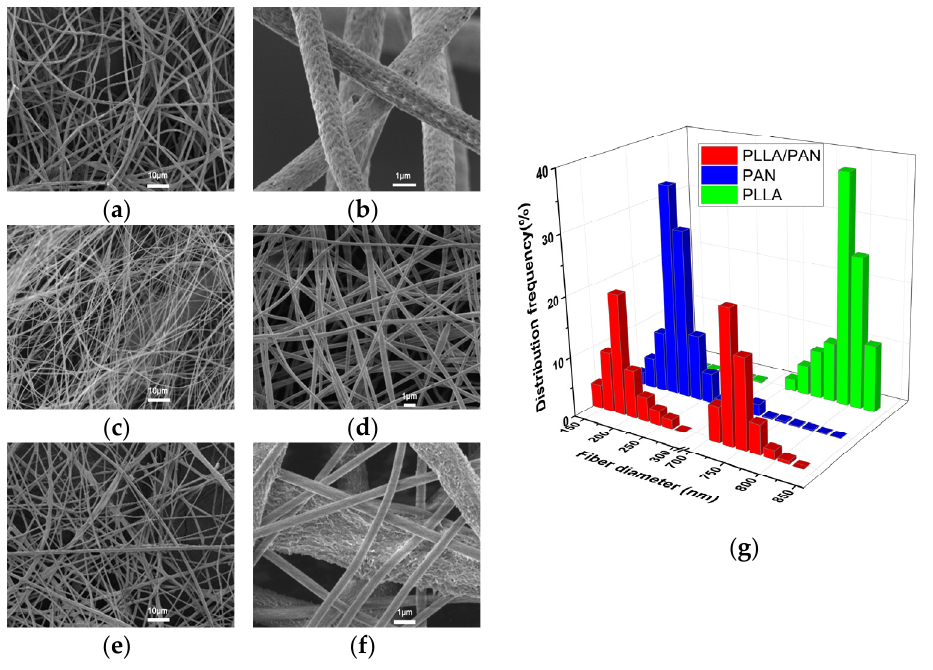
Figure 2. SEM and fiber diameter distribution of the samples, ( a , b ) PLLA fiber, ( c , d ) PAN fiber, ( e , f ) PLLA/PAN composite fiber, ( g ) the fiber diameter distribution.